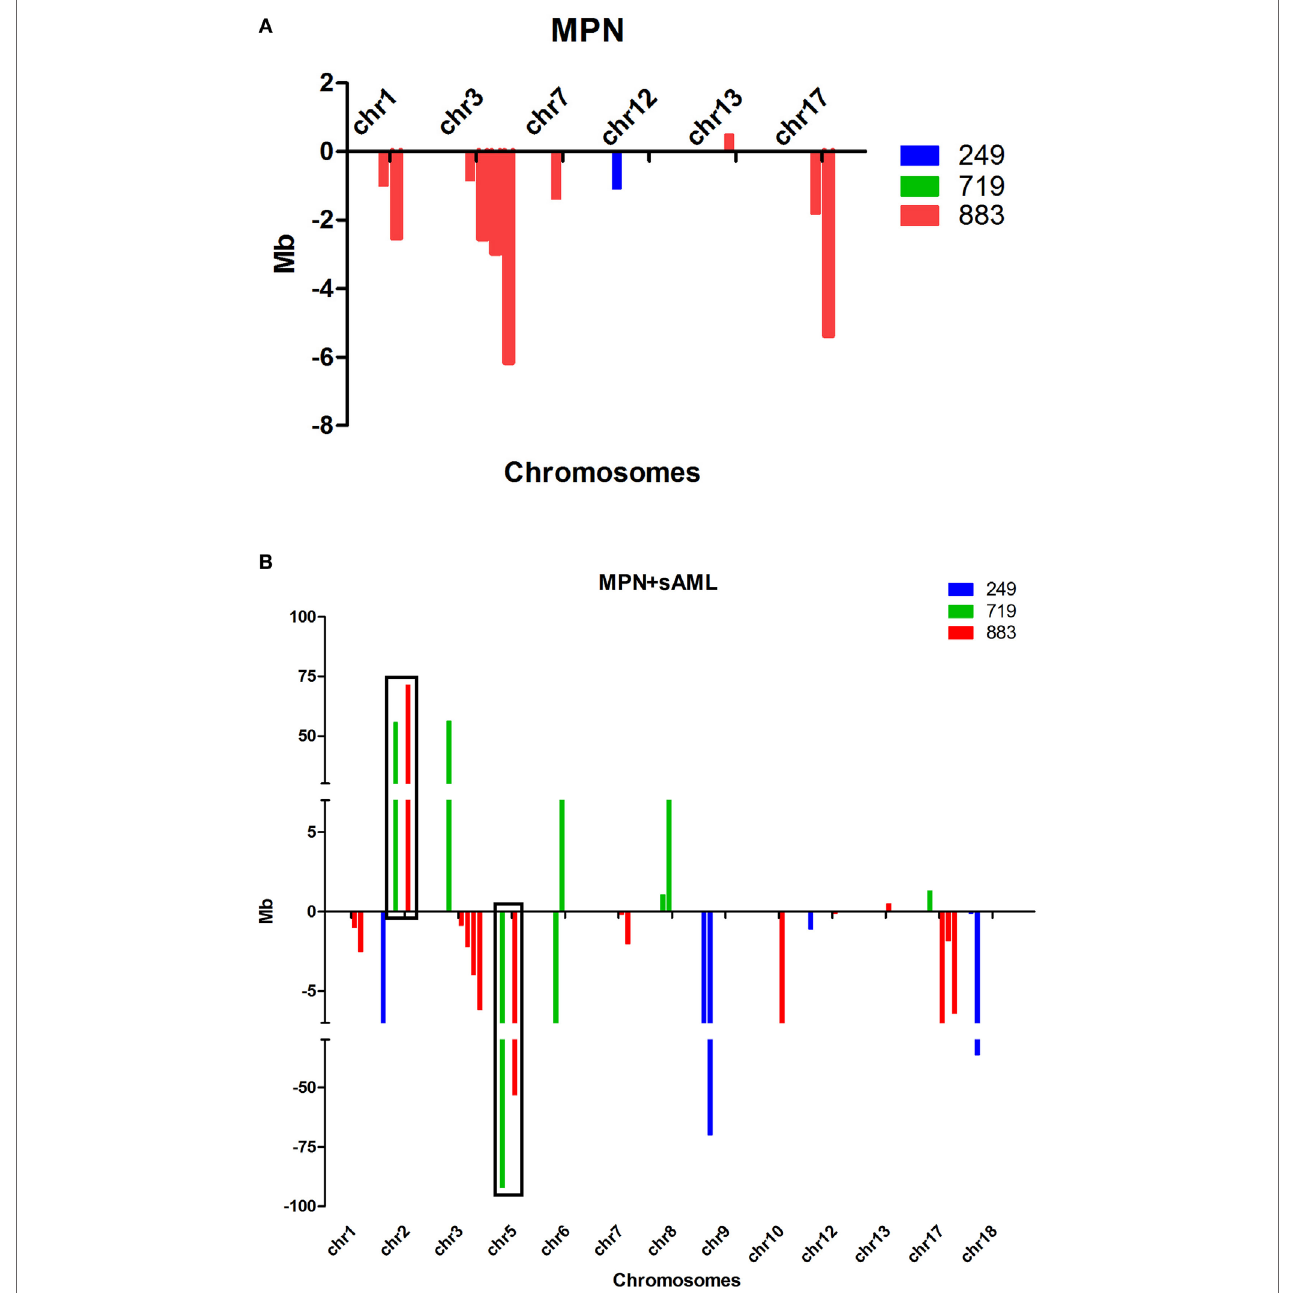
FigUre 2 | (a,b) Size and type of the abnormalities found at chronic phase (a) and sAML (b) samples from three patients analyzed by aCGH. Abnormalities found at chronic phase remained until sAML. Gains are represented above and losses below X-axis; note that there are more abnormalities found at sAML, and they are larger compared to chronic phase. aCGH, array-based comparative genomic hybridization; chr, chromosome; MPN, myeloproliferative neoplasms; sAML, secondary acute myeloid